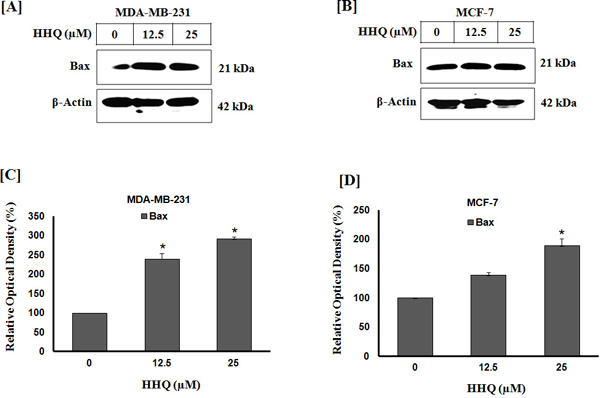
Expression analyses of pro-apoptotic protein Bax in response to HHQ treatment in human breast cancer cells (MDA-MB-231 and MCF-7). The breast cancer cells were treated with 12.5 μM and 25 μM of HHQ for 48 h at 37 °C. Representative western blot hybridization signals of Bax for MDA-MB-231 [A] and MCF-7 [B] and the quantitation of the signals is shown in [C] and [D], respectively. Significant increase in Bax expression was observed in HHQ treated cells. Data are presented as mean ± SEM of three independent experiments. *p< 0.005 represents statistical significant difference between control and HHQ test groups.